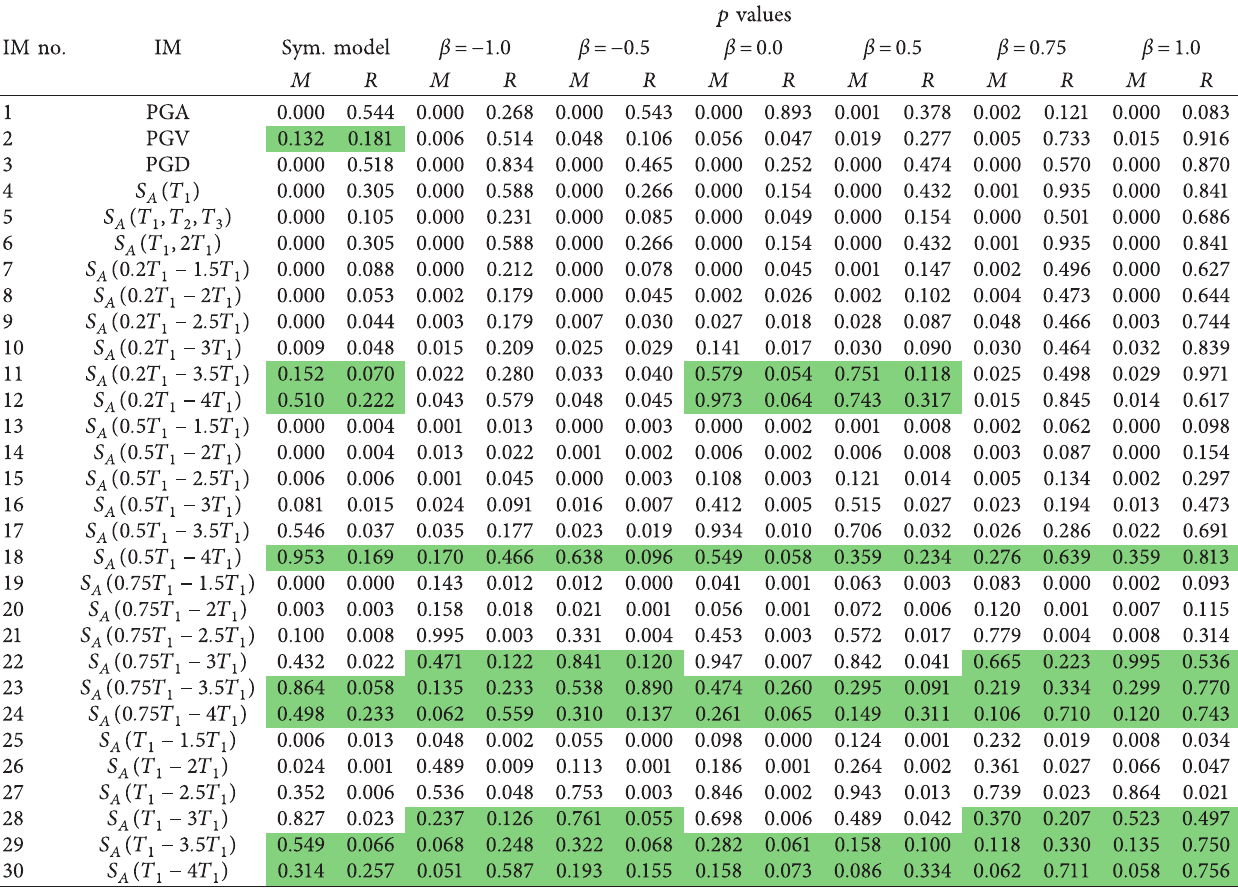
Table 7: The p values obtained from regression analysis for all IMs.